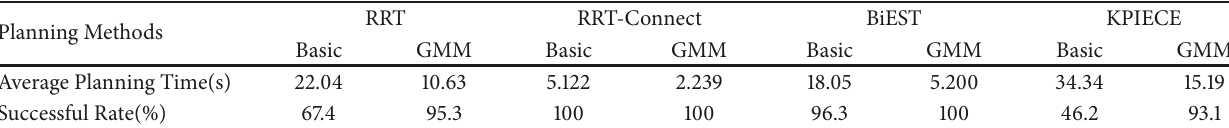
Figure 10: A 6-DOF UR10 robot is used to pick and place a cup in various home environments, and the universality of the proposed method is verified. The green grid represents occupied space stored in the octree data structure, and the blue line represents the trajectory of the end effector when the robot performs the pick and place task. Table 1: Planning performance of the motion planning